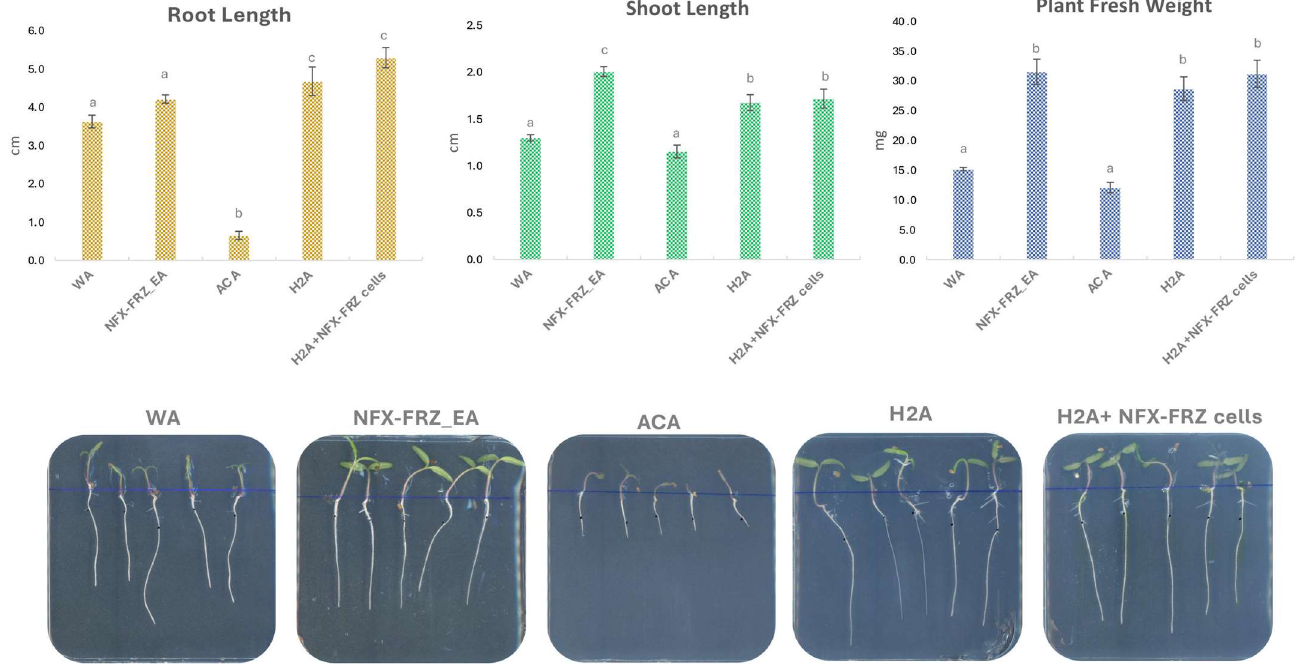
Figure 4. Results obtained from the tomato plant growth promotion assays. Different letters above the bars represent statistical differences ( p < 0.05). WA—water agar; NFX-FRZ_EA—NFX-FRZ exudates agar; ACA—algae culture agar (1.5X algae culture broth + 0.5% Agar); H2A—Hoagland’s No. 2 basal salt agar.